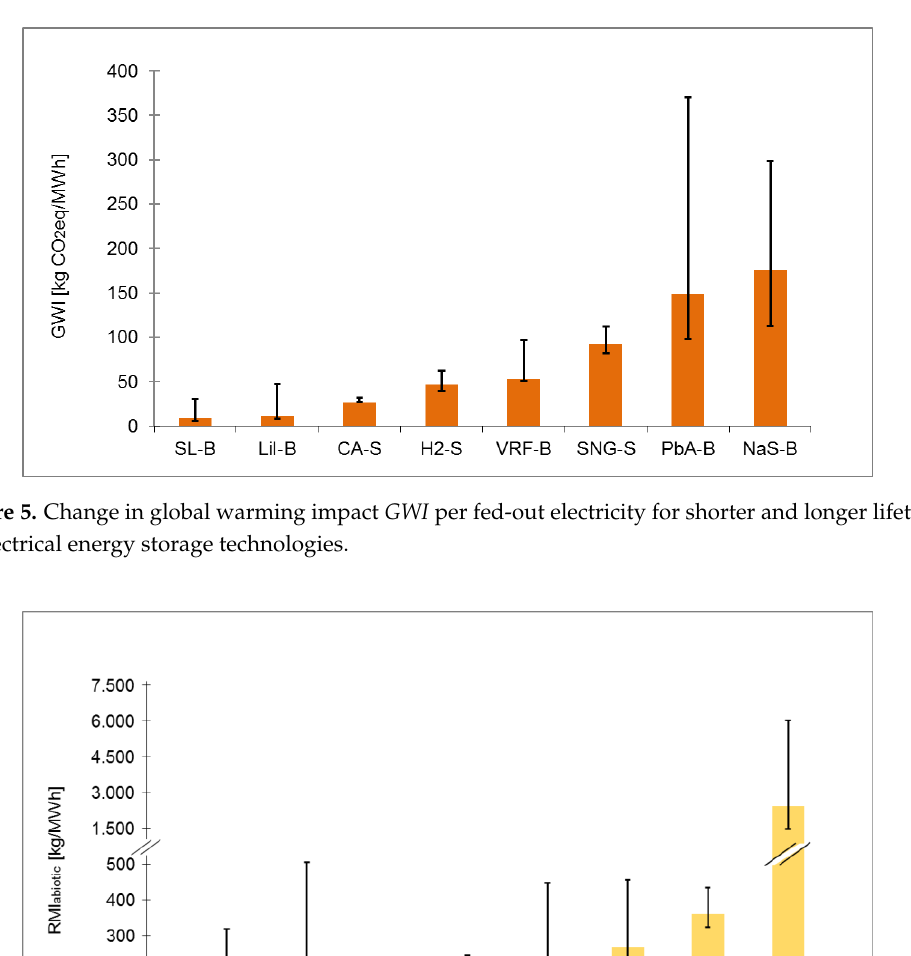
Figure 7. Change in global warming impact GWI per fed-out electricity for increasing the storage capacity of electrical energy storage technologies from 2 to 8 MWh. For all batteries, except the VRF-B, the capacity increase is achieved by interconnecting the fourfold number of battery modules (stacking). As the impact indicators are normalized per fed-out electricity, the stacking does not lead to a change in the carbon and material footprint. The capacity of the VRF-B is increased by a larger container, bigger components, more electrode material and a greater amount of electrolyte. The CA-S requires more material, bigger components and a higher volume of thermal oil. The capacity of the SNG-S and the H 2 -S is increased just by scaling up of the power-to-gas plants as they use the gas grid as storage. The GWI of the VRF-B is reduced by 19.6% and of the CA-S by 25.2%. The GWI of the H 2 -S is reduced by 74.1% (close to the value of the LiI-B) and of the SNG-S by 77.5% (close to the value of the CA-S). The detailed data are shown in the Appendix A (Table A7). The change in RMI abiotic per fed-out electricity for increasing storage capacity from 2 to 8 MWh is shown in Figure 8.